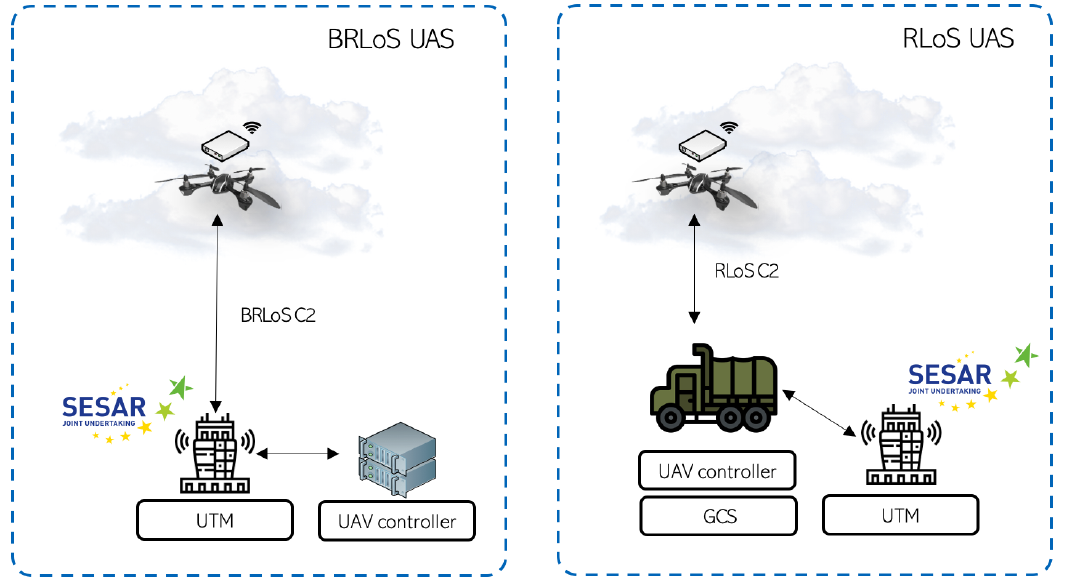
Figure 1. Different types of UAS following UTM: Beyond Radio LoS (BRLoS), and Radio LoS